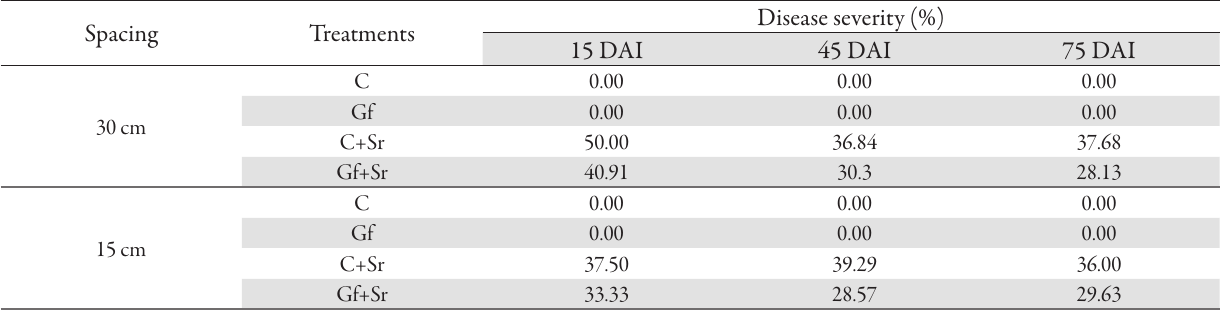
Tab. 2. Disease incidence (%) and dead plants in A. hypogaea L. after 15, 45 and 75 days of S. rolfsii inoculation in 30 and 15 cm plant spacing